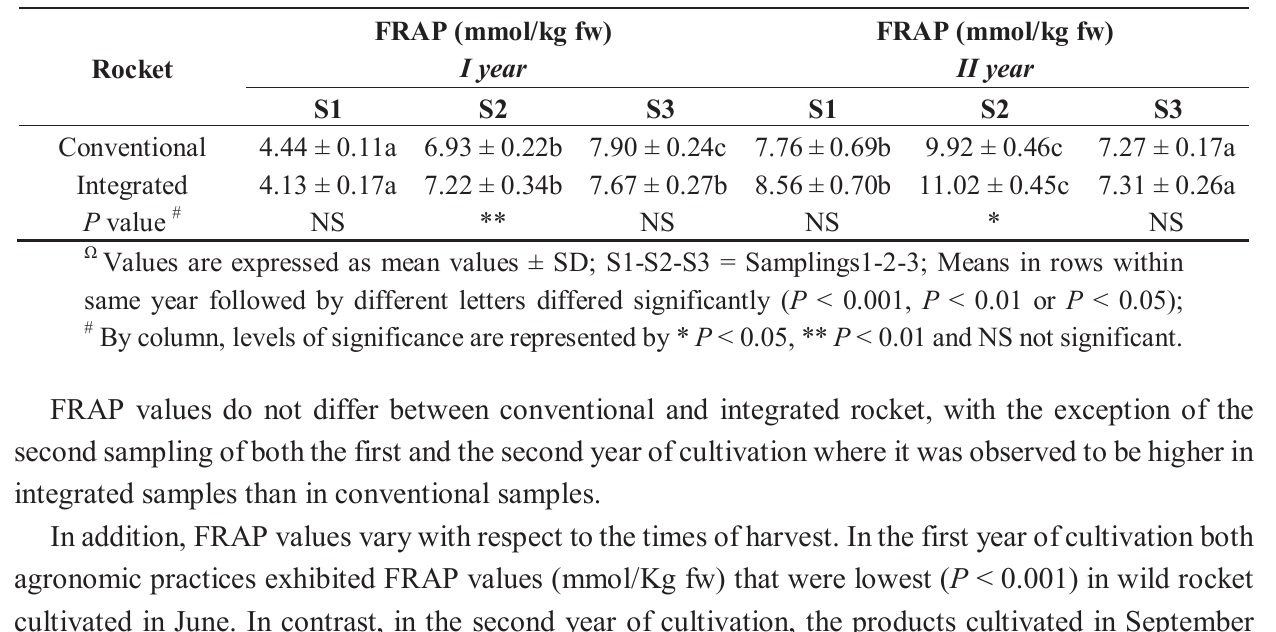
Table 2. FRAP values of rocket distributed by agronomic practice and year of cultivation (cid:525) .